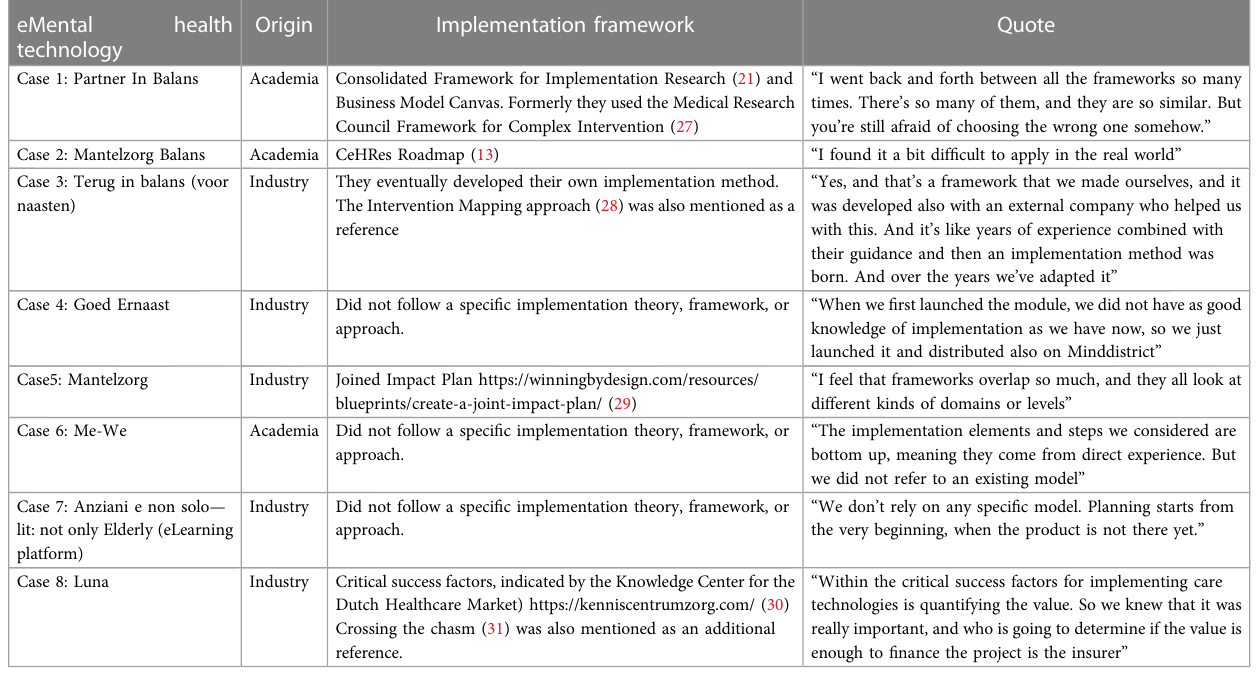
TABLE 1 Experiences with implementation theories, models, and frameworks.